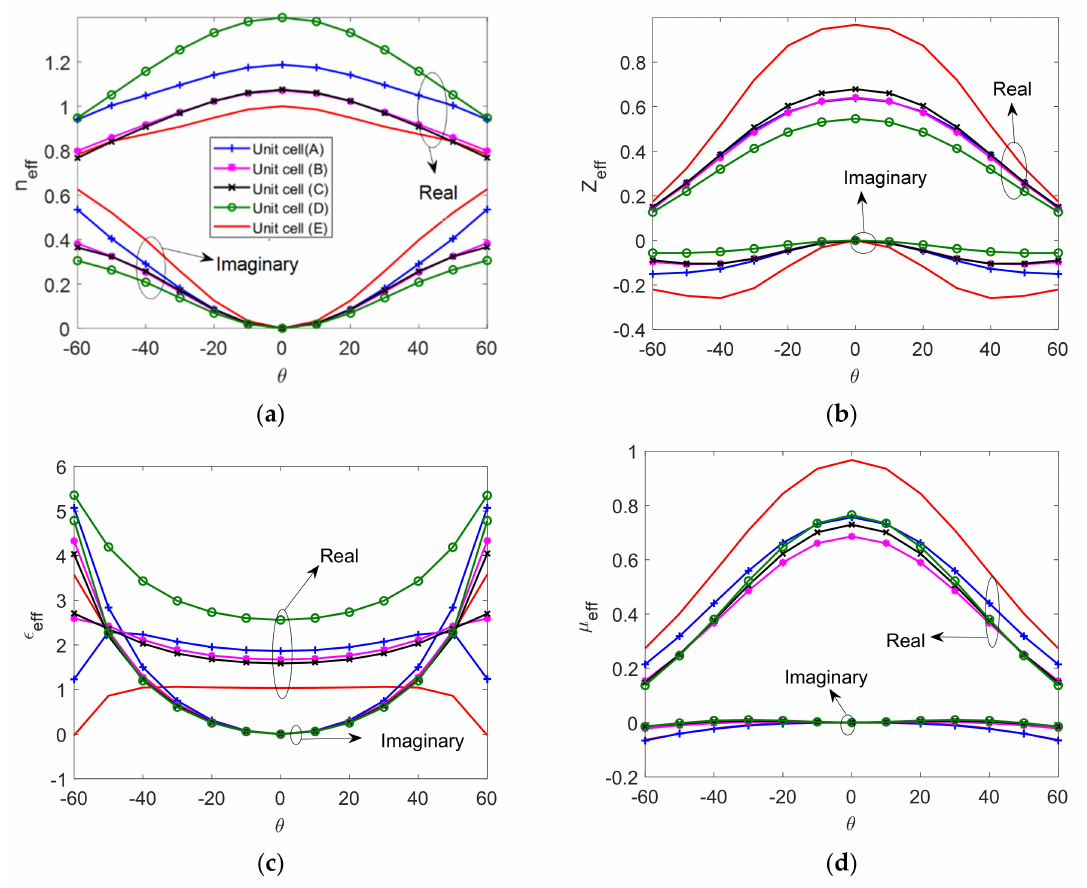
Figure 11. Effective EM parameters versus θ . ( a ) The effective refractive index, ( b ) the effective wave impedance, ( c ) the effective permittivity, and ( d ) the effective permeability.